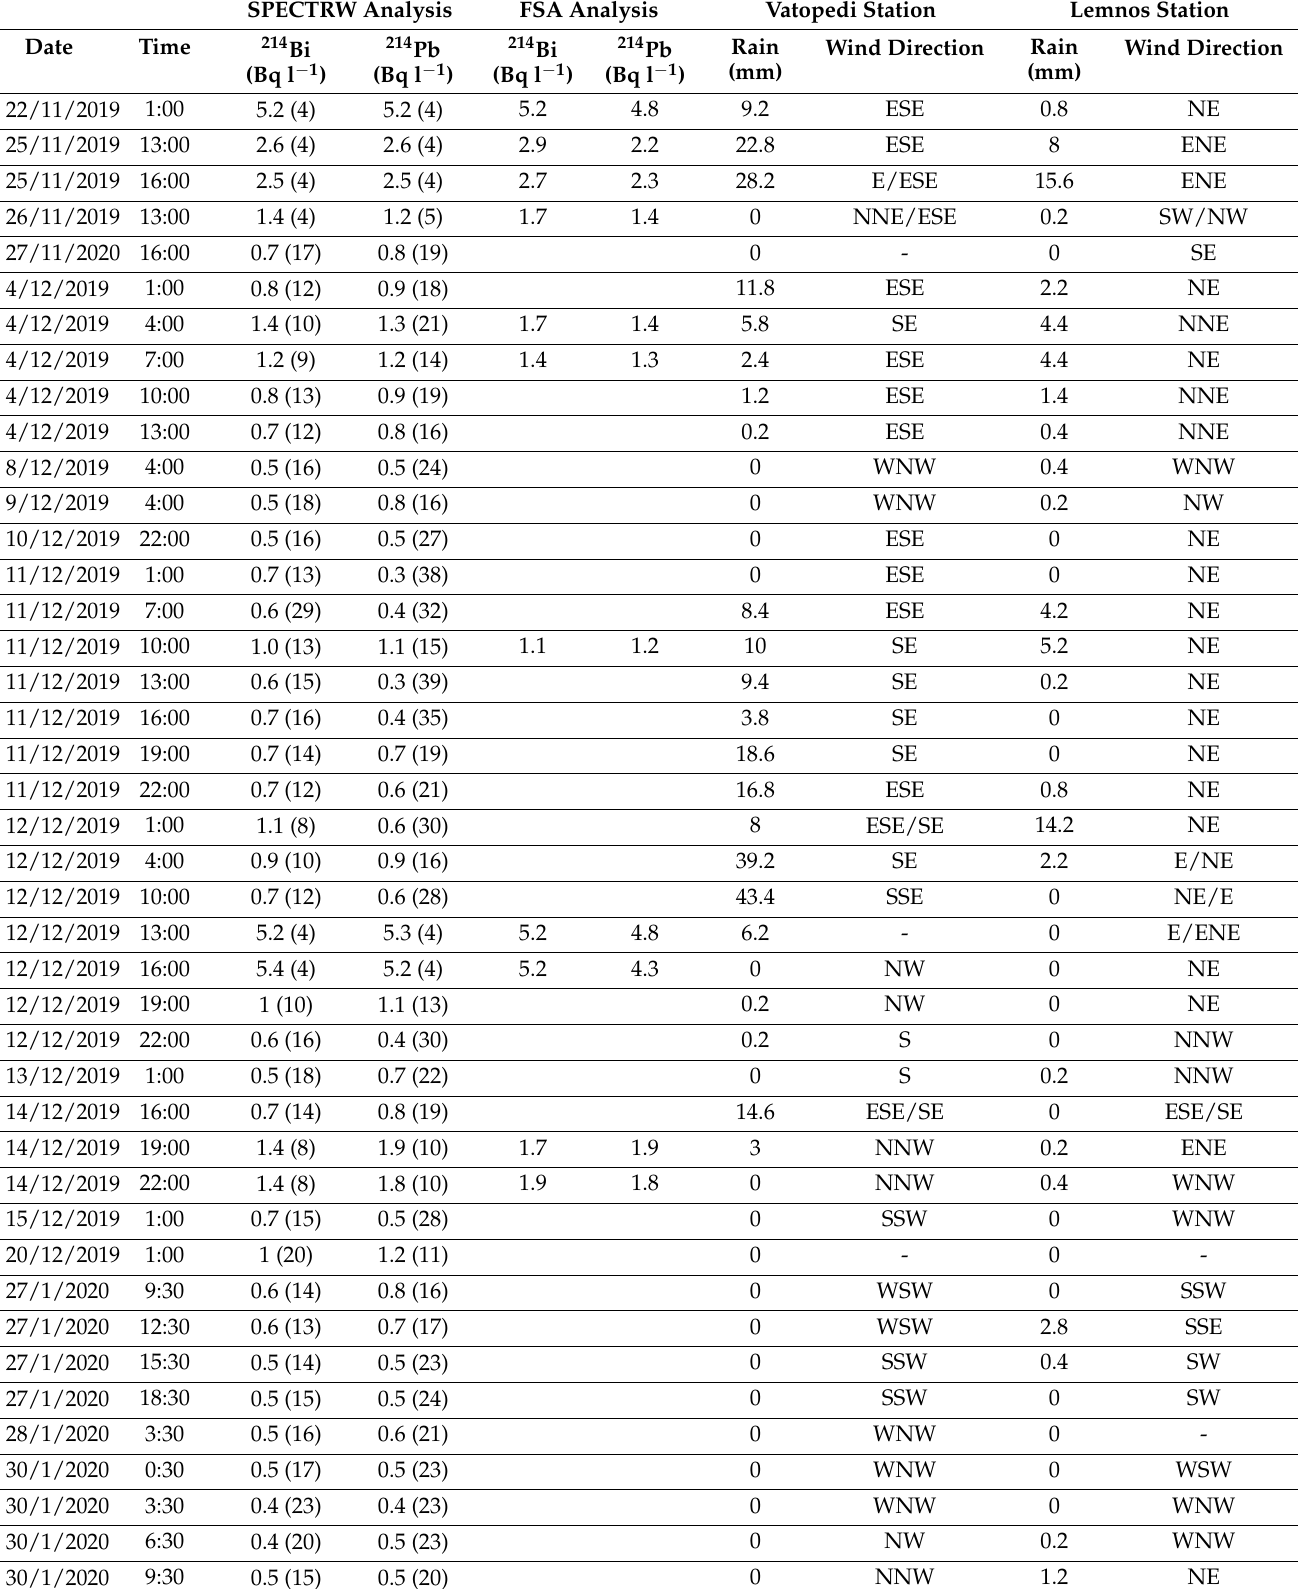
Table 1. The activity concentration of radon progenies ( 214 Bi and 214 Pb) during rainfalls analysed with the SPECTRW software and the FSA method. The time-normalized meteorological data of two neighboring stations (Vatopedi and Lemnos) are also